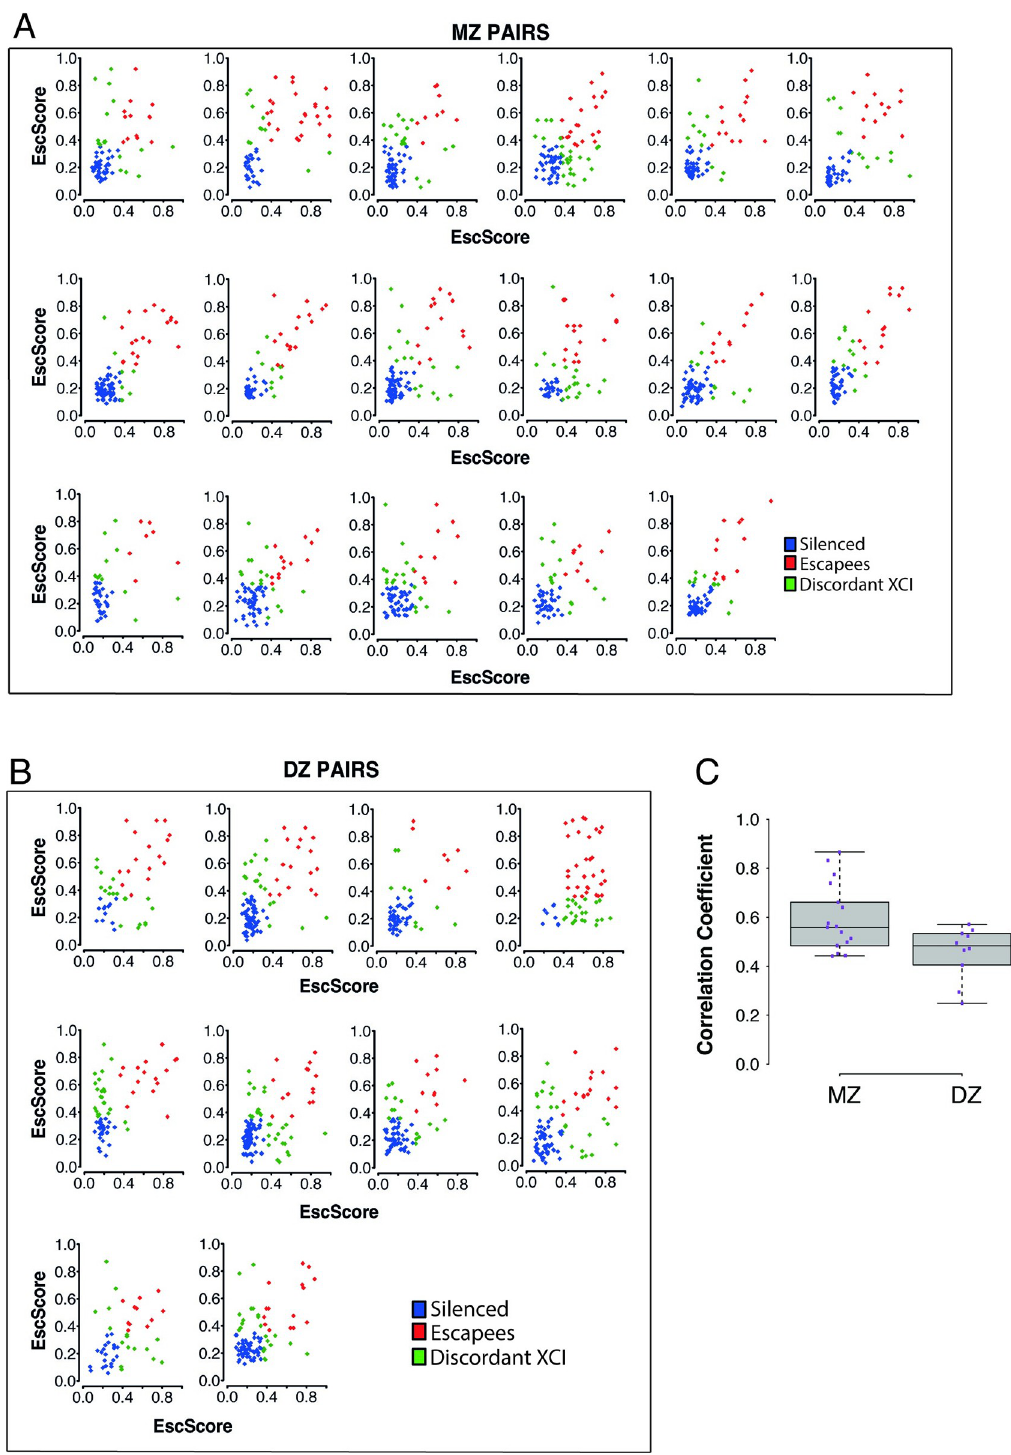
Fig 4. Scatterplots of EscScore(s) of genes ( � 5) with data available in both co-twins of a pair. A total of 27 complete twin pairs (both co-twins exhibiting skewed XCI in LCLs) were used. Each dot represents a gene, colored in blue if silenced in both co- twins, red if escaping XCI in both co-twins, and green if exhibiting discordant XCI (escaping only in one co-twin). (A) Monozygotic (MZ) twin pairs (N = 17); (B) Dizygotic (DZ) twin pairs (N = 10). (C) Boxplots of coefficients of correlation between EscScore(s) in the two co-twins of each